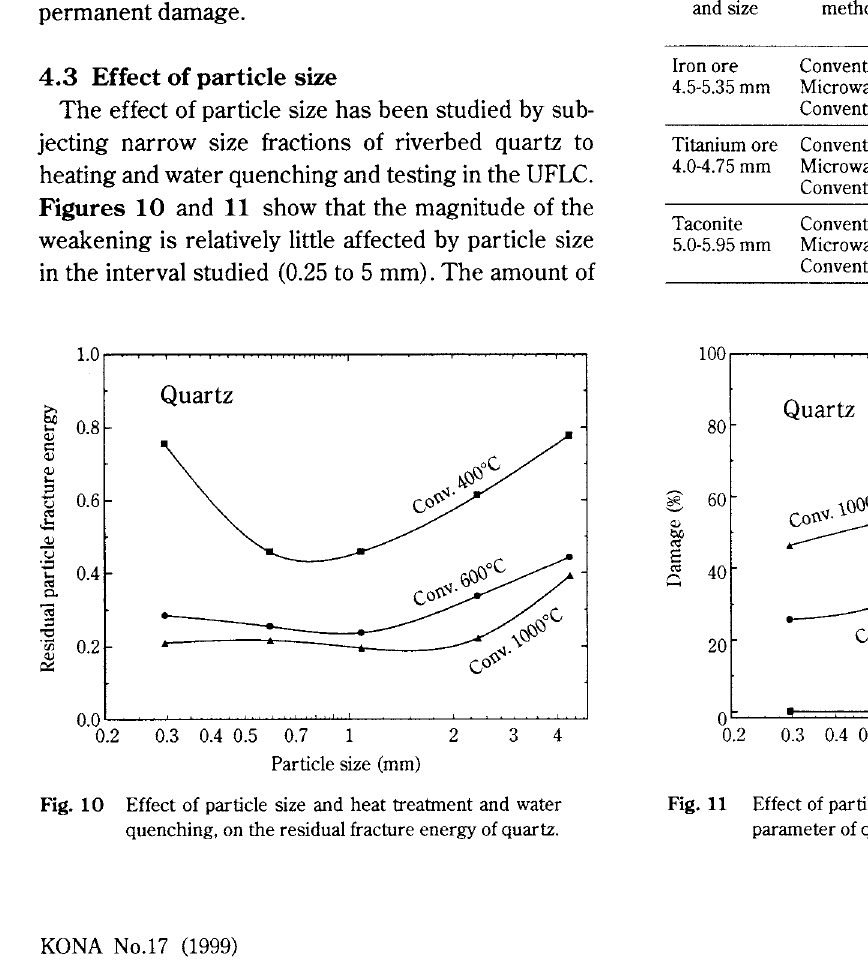
Fig.lO Effect of particle size and heat treatment and water quenching, on the residual fracture energy of quartz.